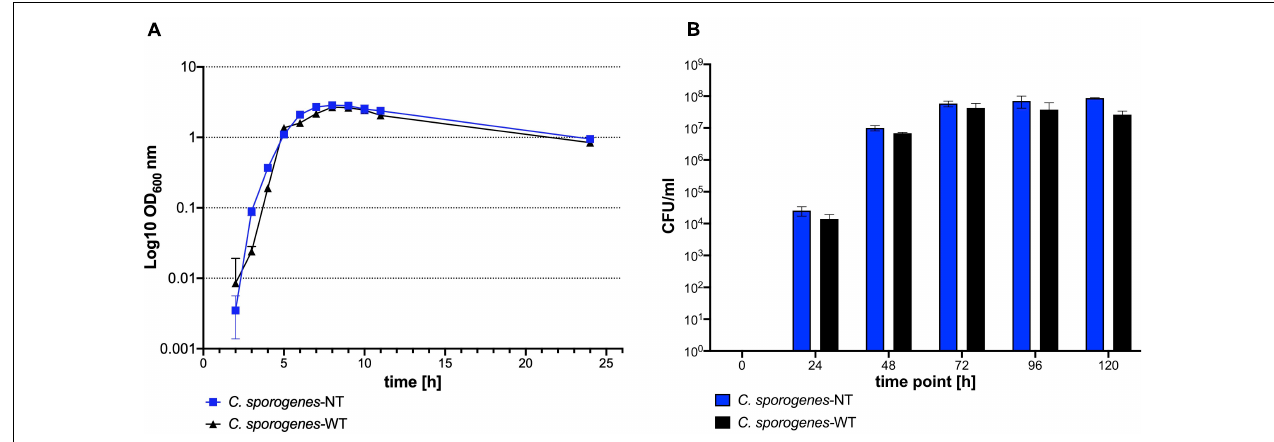
FIGURE 3 | Growth and development of heat resistant colony forming units of C. sporogenes -NT (blue) and C. sporogenes -WT (black) strains. (A) Growth of Clostridium strains was measured as a direct increase in absorbance at 600 nm throughout the course of 24 h bacterial incubation in bovine free medium (PYT). The symbols represent the average of three independent experiments, and error bars indicate the standard errors of the means. (B) Heat-treated bacterial samples (80 ◦ C, 20 min) were plated in serial dilution on PYT agar plates and enumerated following 24 h incubation. Bars represent the number of CFU (colony forming unit) per ml of Clostridium culture. The data represent the average of three independent experiments and error bars indicate the standard error of the mean. The sporulation-deficient Clostridium sporogenes- NT (cid:49) spo0A mutant was used as a negative control to rule out experimental error. The detection limit for colony counts was 50